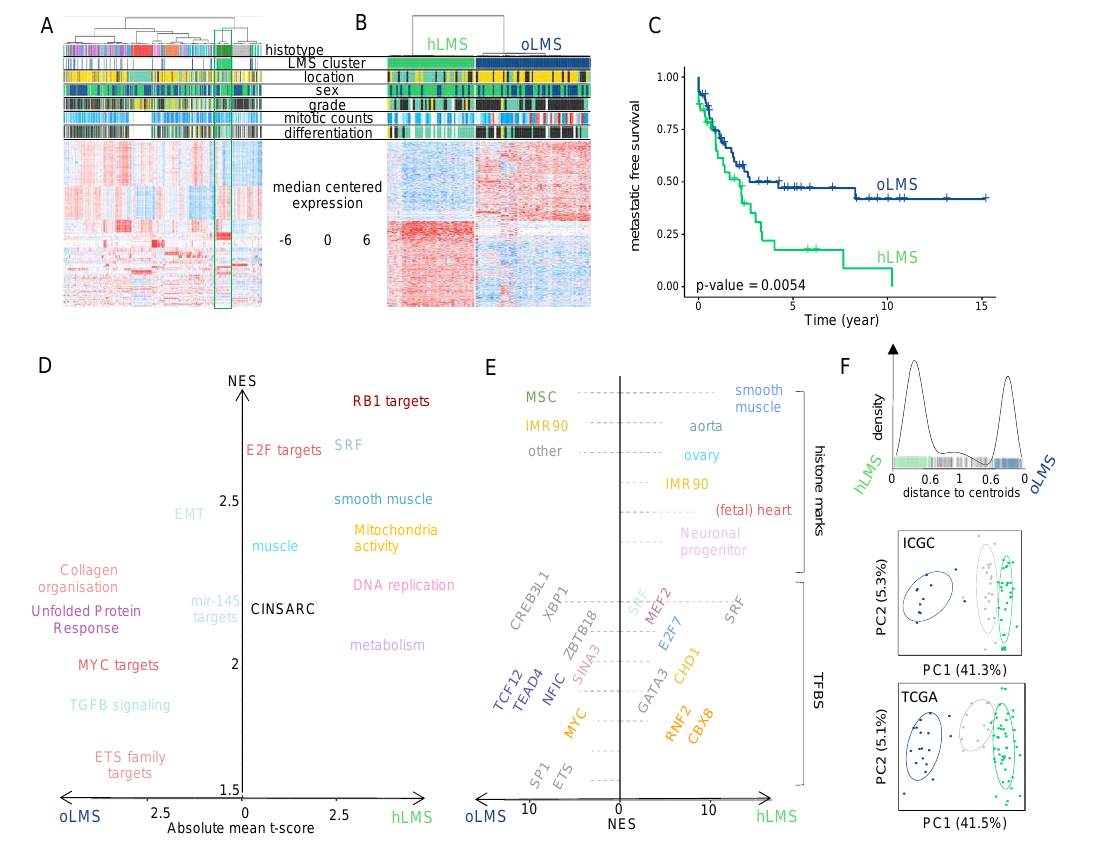
Figure 1. Transcriptional analysis and patient classification: ( A , B ). Heatmaps showing clustering of 555 sarcoma patients and 455 genes ( A ) and 98 LMS patients and 1672 differentially expressed genes between hLMS and oLMS ( B ). Patients were clustered using HCPC method, and genes were grouped by co-expression modules. Color schemes. Histotype: green forest: leiomyosarcomas, red: GIST, pink: undifferentiated sarcomas, orange: myxoid liposarcomas, blue: dedifferentiated sarcomas, grey: synovial sarcomas, turquoise: other sarcomas. Location: yellow: extremities, green: internal trunk, black: trunk wall. Sex: green: female, blue: male. Grade and differentiation: yellow: 1, green: 2, black: 3. Mitotic count: blue to red: from low to high: A—0 to 120, B—0 to 60. Cluster: green: hLMS, blue: oLMS. ( C ). Kaplan-Meier metastasis-free survival analysis in hLMS and oLMS. The number indicates the Log-Rank test p -value. ( D ). GSEA analysis on z-scores obtained from hLMS/oLMS gene expression comparison. Each dot is an enriched term (FDR < 0.01); size corresponds to the number of genes involved; the x -axis contains the mean t-score of all genes annotated in the given term, and the y -axis corresponds to the GSEA NES score. Related terms are colored the same way. ( E ). i-Cistarget analysis of 843 under- and 800 over-expressed genes in hLMS relative to oLMS. The x -axis represents the NES score obtained for over-expressed genes from 0 to the right and under-expressed genes from 0 to the left. The left and right parts are independent; the enriched features were clustered on the y -axis according to the cell type or tissue they were analyzed from. Histone modifications are only active transcription marks (H3K4me1, H3K4me3, H3K27ac, and H3K9ac). Detailed legends for E-F are available in Table S3C,D, respectively. ( F ). Top panel: distance distribution to centroids ( x -axis) computed from transcriptional signature for ICGC and TCGA patients (bars on the x -axis). Colors correspond to cluster assignation: patients with a distance lower than 0.6 to one of the centroids were assigned to the corresponding centroid (green: hLMS, dark blue: oLMS), while patients with intermediate value were not classified (light grey). Middle and bottom panels: PCA analysis using transcriptional signature genes in ICGC and TCGA cohorts. Each point is a patient, green: hLMS, dark blue: oLMS, and light grey: not classified. x -axis and y -axis represent principal components 1 and 2 and their associated variance representation,